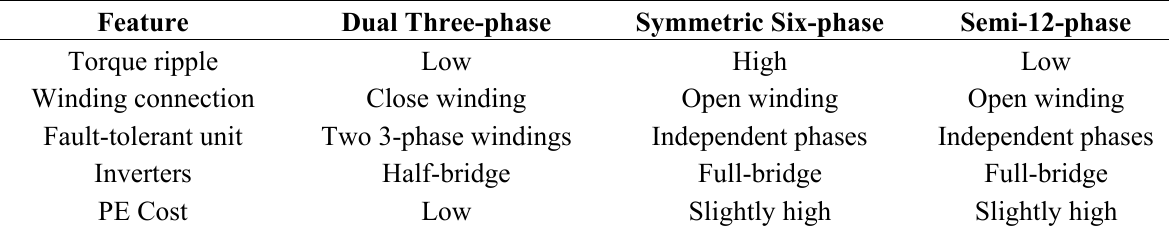
Table 1. Comparison of three six-phase PMSM